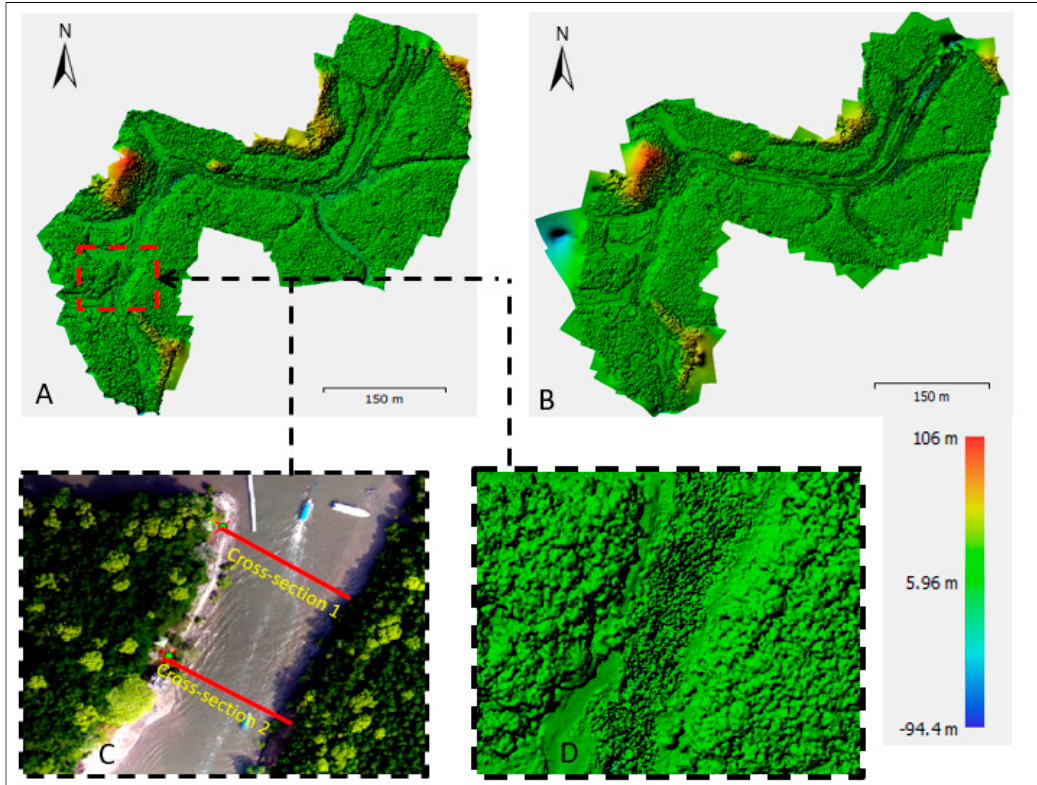
Figure 7. The DSM of the Kilim River; ( A ) At high tide (Epoch 1); ( B ) At low tide (Epoch 2); ( C ) Cross sections 1 and 2 in the orthomosaic image; ( D ) DSM at the area of cross sections 1 and 2.